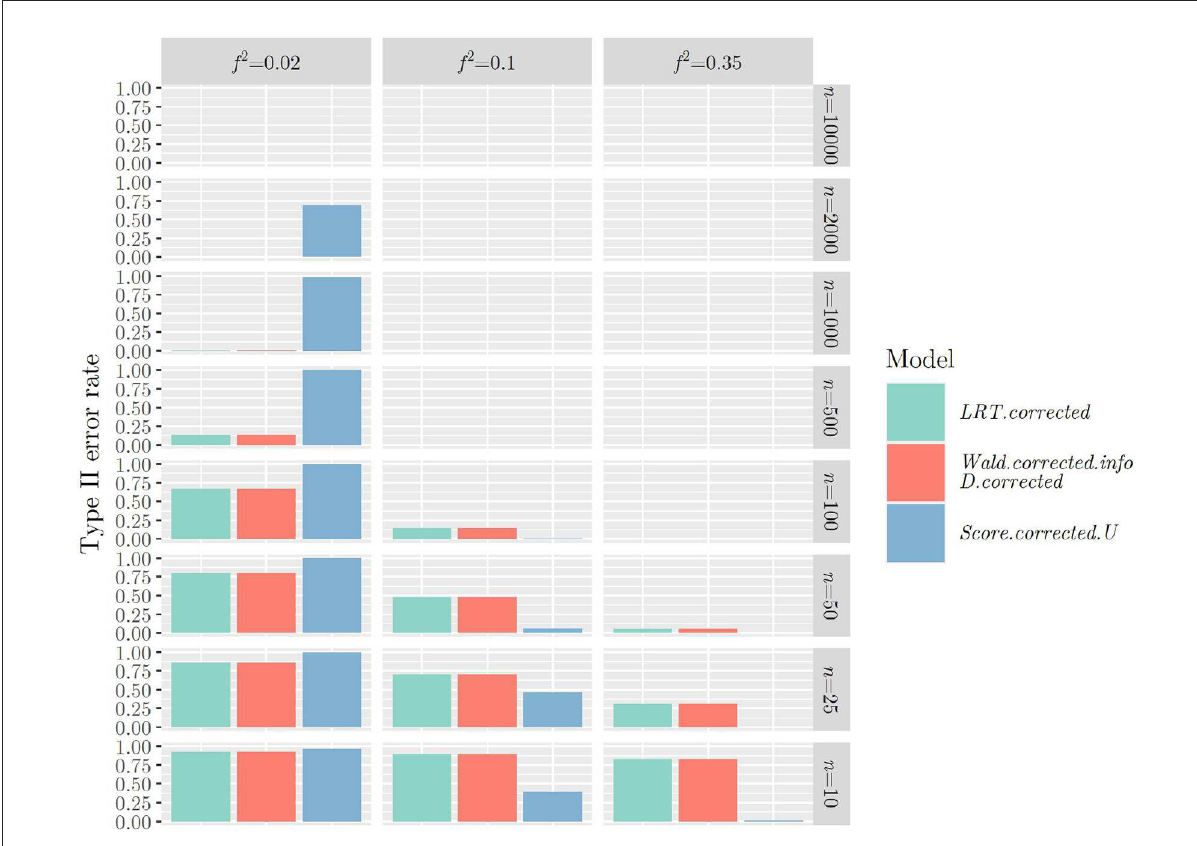
FIGURE4 Type II error rates when using R 2 , ˆ S 2 corrected (or ˜ S 2 corrected , ¯ S 2 corrected ) and the ¯ F -distribution for calculating the p